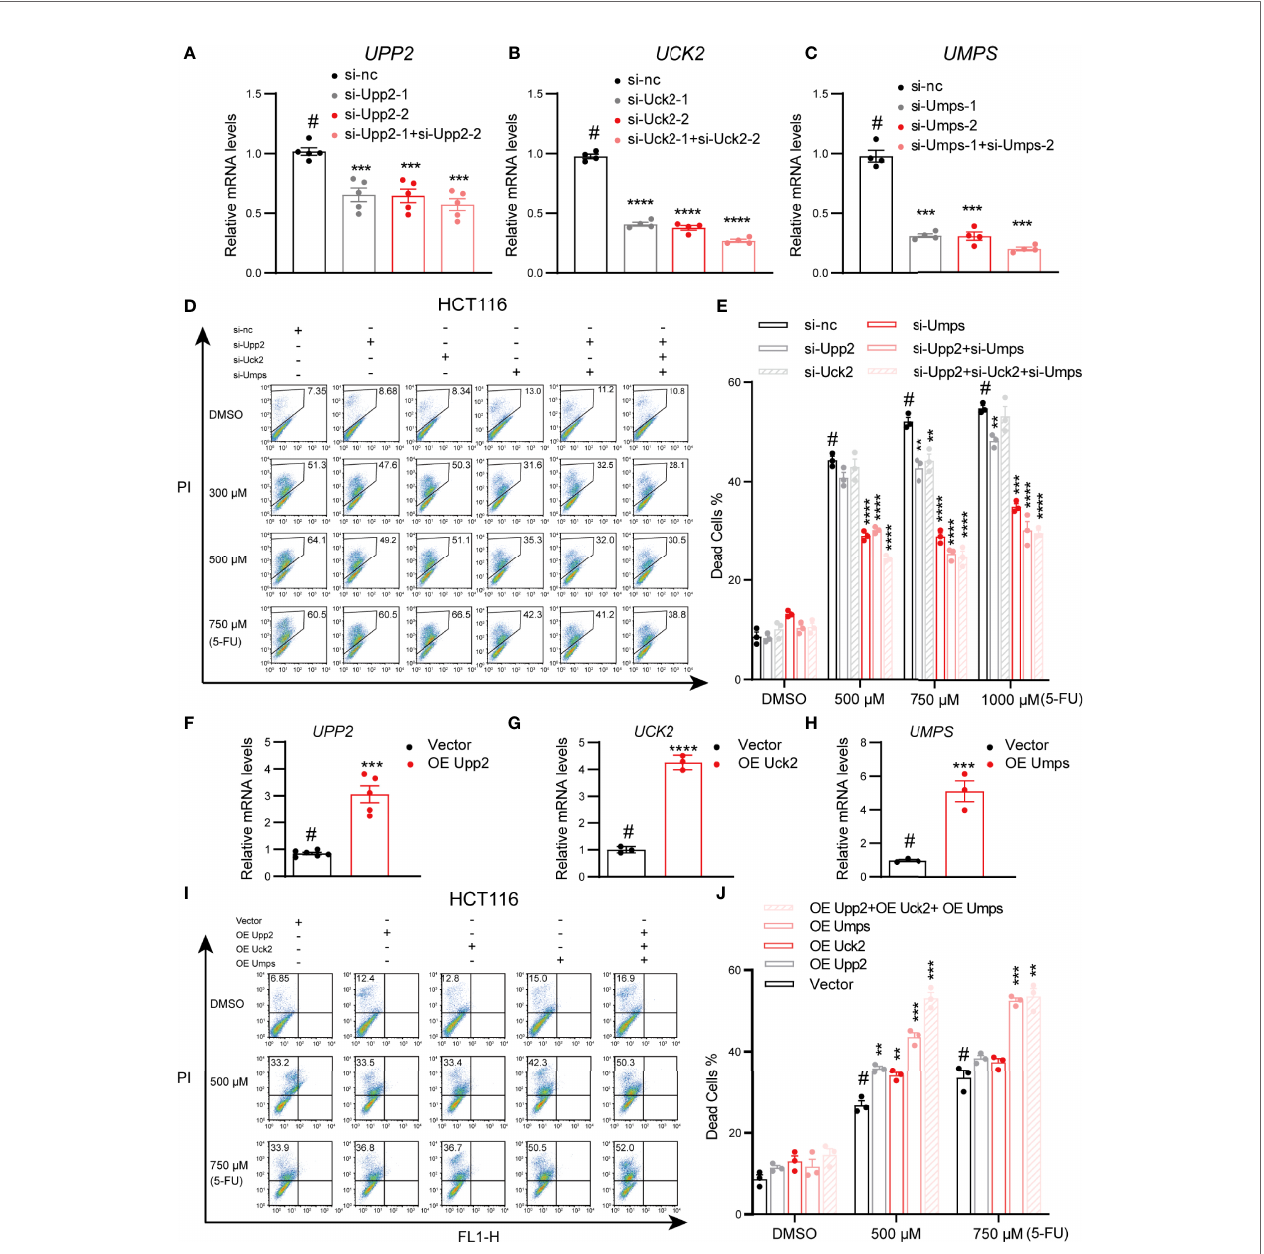
FIGURE 3 | Genetic deletion of pyrimidine pathway genes promotes robust 5-FU resistance in HCT116 cells. (A – C) Validation of the knockdown ef fi ciency of UPP2 by qPCR in HEK293T, and validation of the knockdown ef fi ciency of UCK2 and UMPS in by qPCR in HCT116 cells. (D, E) Dead cells were determined by fl ow cytometry of HCT116 cells knocking down pyrimidine metabolic pathway genes after treatment with 5-FU (0, 300 m M, 500 m M, 750 m M, 48 h). (n = 3, one-way ANOVA per concentration). (F – H) Validation of the overexpression ef fi ciency of UPP2 , UCK2 and UMPS by qPCR in HCT116. (I, J) Dead cells were determined by fl ow cytometry of HCT116 cells overexpressing pyrimidine metabolic pathway genes after treatment with 5-FU (0, 500 m M,750 m M,48 h). (n = 3, one-way ANOVA per concentration). ** indicates p < 0.01, *** indicates p < 0.005, **** indicates p< 0.001 versus si-nc (#) or vector (#), ns indicates there is no signi fi